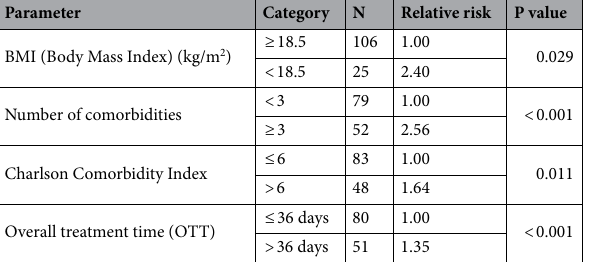
Table 6. The results of multivariate analysis of correlations between selected prognostic factors and overall survival.